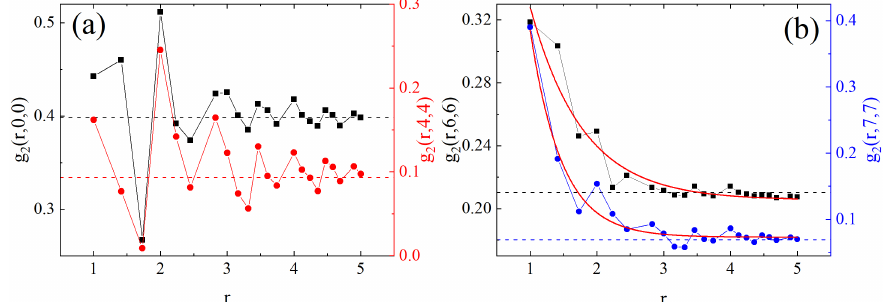
Figure 7. ( a ) Self-correlation functions g 2 ( r , V , V ) for V = 0 (black squares, left y scale) and V = 4 (red dots, right y scale). ( b ) Plot of g 2 ( r , V , V ) for V = 6 (black squares, left y scale) and V = 7 (blue dots, right y scale). Dashed lines: global concentrations of cells with corresponding values of V . Solid lines: exponential fits. T = 0.25. Based on [157].